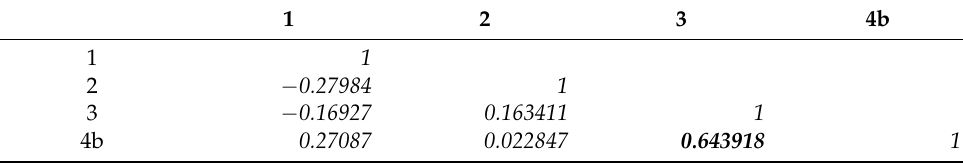
Table 3. Correlation coefficient of observed variables